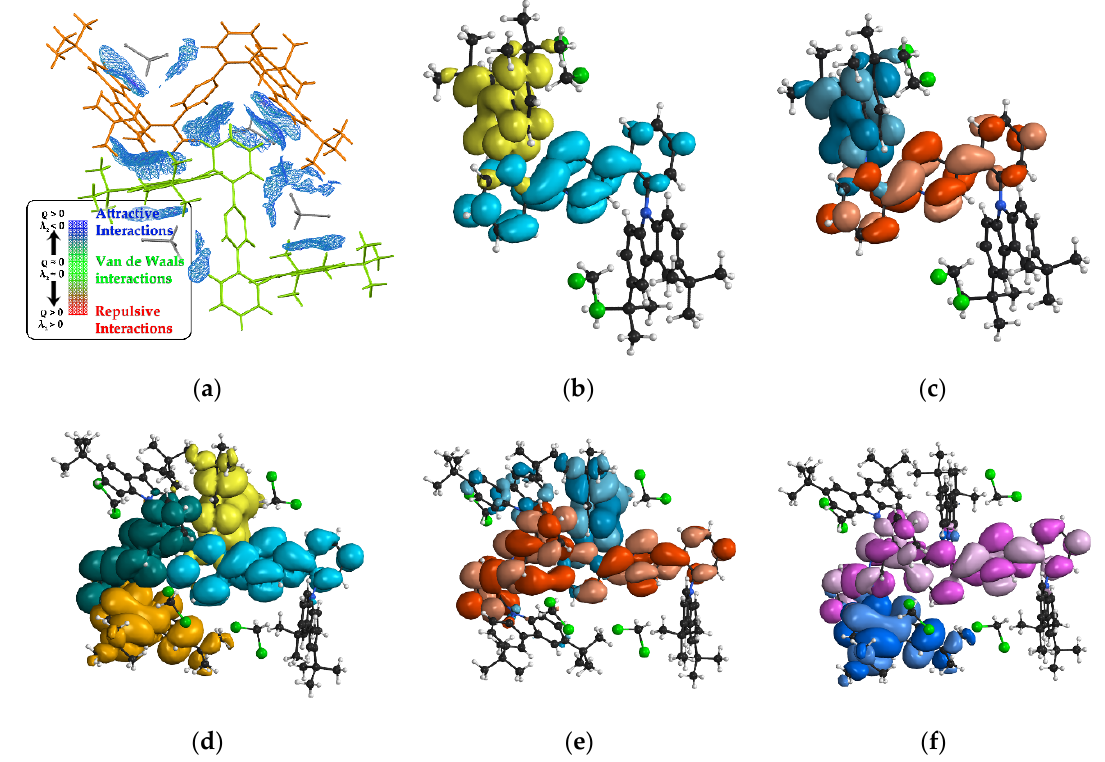
Figure 4. ( a ) The IGMH interactions between two neighboring PDPC molecules. The distribution of ( b ) holes (yellow) and electrons (cyan), and ( c ) HOMO (turquoise)/LUMO (red) orbitals in monomer PDPC ; ( d ) the distribution of holes and electrons in dimer PDPC , under excited state S 1 (hole: yellow; electron: cyan), and its degenerated state S 2 (hole: orange; electron: green). The frontier orbitals of the dimer: ( e ) HOMO (turquoise)/LUMO (red) and ( f ) HOMO-1 (purple)/LUMO+1 (blue).